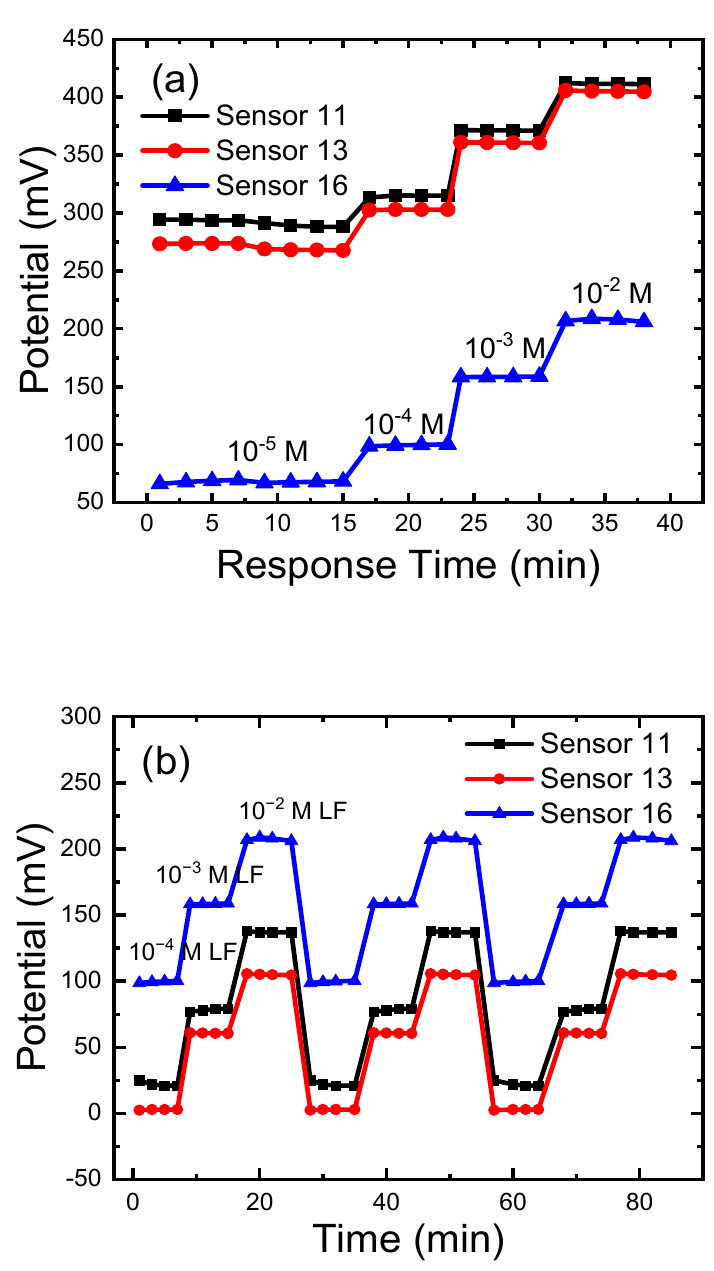
Figure 11. Carbon paste electrode (CPE, sensor 11); PVC membrane coated on carbon paste electrode (C-CPE, sensor 13); PVC/CD plasticized carbon paste electrode (P-CPE, sensor 16): ( a ) response time was monitored by recording the electrodes’ potential in 10 − 5 M, 10 − 4 M, 10 − 3 , 10 − 2 LF solution. ( b ) reversibility was followed by recording the electrodes’ potential in 10 − 4 M, 10 − 3 , 10 − 2 LF solution. All measurements at pH 4.1 using acetate buffer at room temperature of 22 ± 2 ◦ C. The electrode compositions (%, wt / wt ) are given in (Table 1).